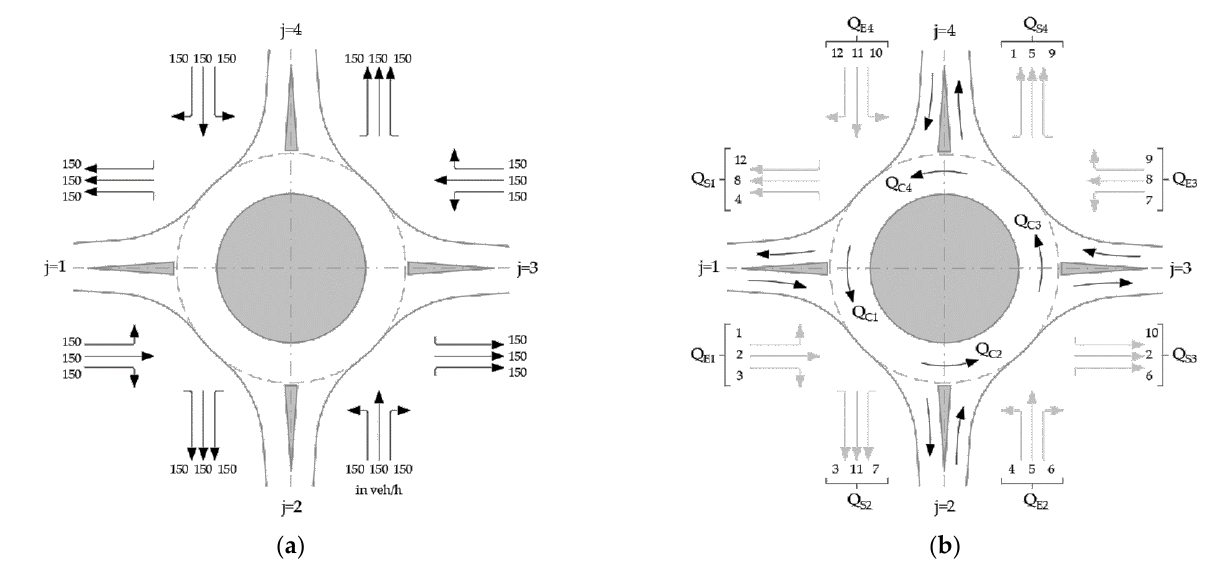
Figure 4. Traffic flows at a four-legged roundabout: ( a ) each entry in each travel direction, in veh/h; ( b ) entering, exiting, and circulating the roundabout. Table 2. Calculation of entering, exiting, and circulating traffic flow.